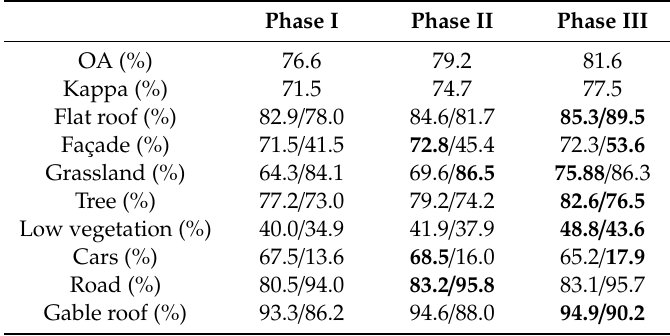
Table 3. Comparison of the classes’ accuracies for the three phases in combined Vaihingen sites. Bold numbers show the highest values among the three